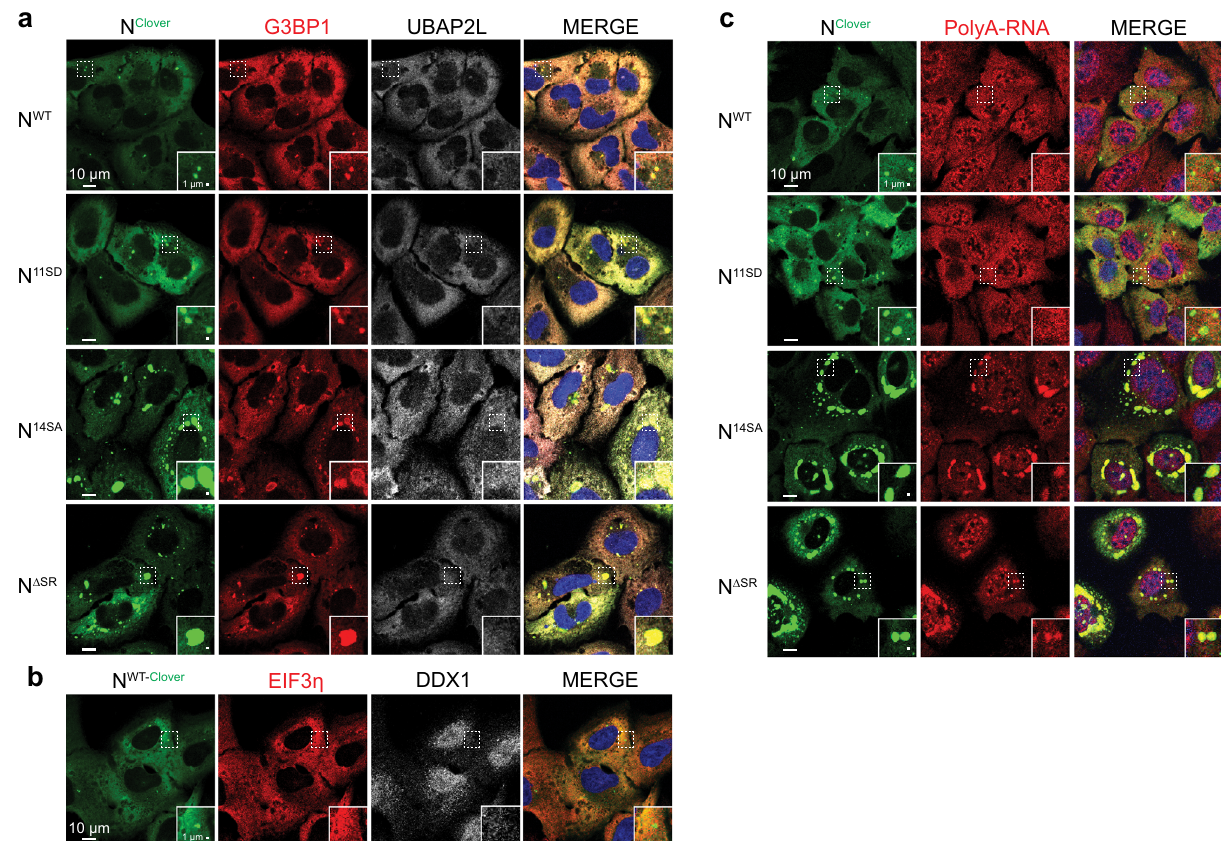
Fig. 6 SARS-COV-2 N protein condensates recruit G3BP1, but not other stress granule proteins. a Representative fl uorescence images of Clover-tagged N protein condensates (green), plus G3BP1 (red) and UBAP2L (white). b Representative fl uorescence images of Clover-tagged N WT condensates (green), plus EIF3 η (red) and DDX1 (white). See Supplementary Fig. 7 for equivalent images of N 11SD , N 14SA , and N Δ SR . c Representative fl uorescence images of Clover-tagged N protein condensates (green) and Poly-A RNA (oligo-dT FISH; red) from three to four images taken in each